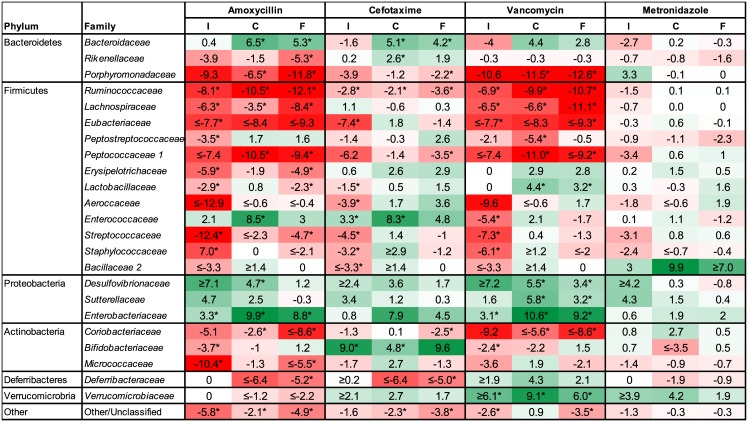
Fold change of bacterial families for treatment groups compared to the control group in ileum, caecum and faeces.Values show fold-changes (log2) in relative abundance (rel. abun.) of bacterial families in ileum (I), caecum (C) and faeces (F) of antibiotic treated groups (ABX) compared to the same bacterial groups in the control (CON) group (log2(rel. abun. ABX / rel. abun. CON)). Only bacterial families which change significantly are shown. Intensity of green and red shading indicate levels of increase or decrease respectively and asterisks indicate significant differences after correcting for multiple testing (q<0.05). When no reads were observed for a specific family, a value of 0.0005% was applied as a lower detection limit for calculations (fold-changes indicated with ≤ or ≥).